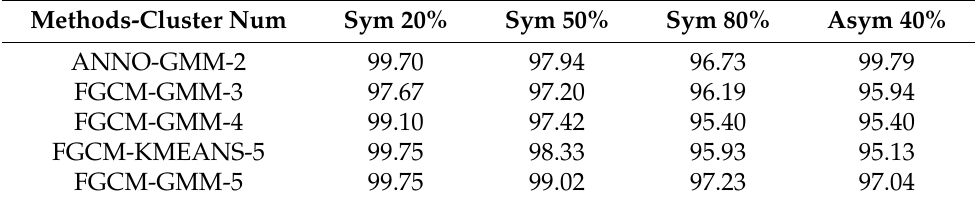
Table 7. Precision of obtained labels using different clustering methods and cluster numbers on CIFAR-10 with different type and ratios of noise. ANNO-GMM-2 denotes experiment that only uses the confidence of annotation label to divide samples into two categories.